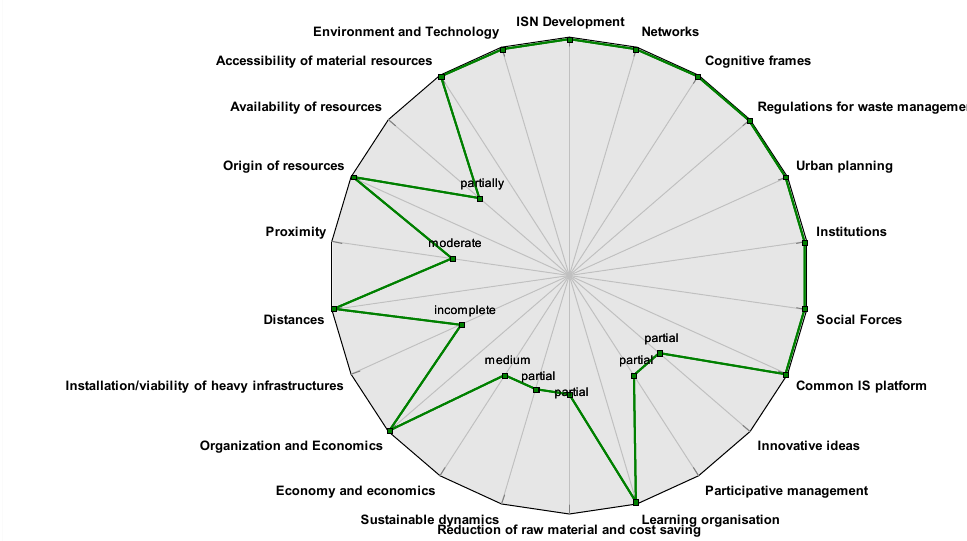
Figure 2. Polar charts of the selected attributes for ISN in Kalundborg.